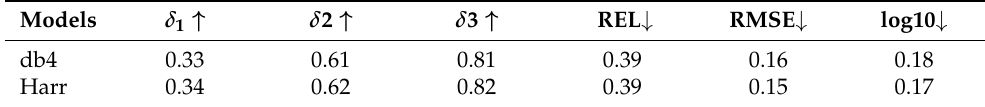
Table 2. Performance of model with different wavelets.